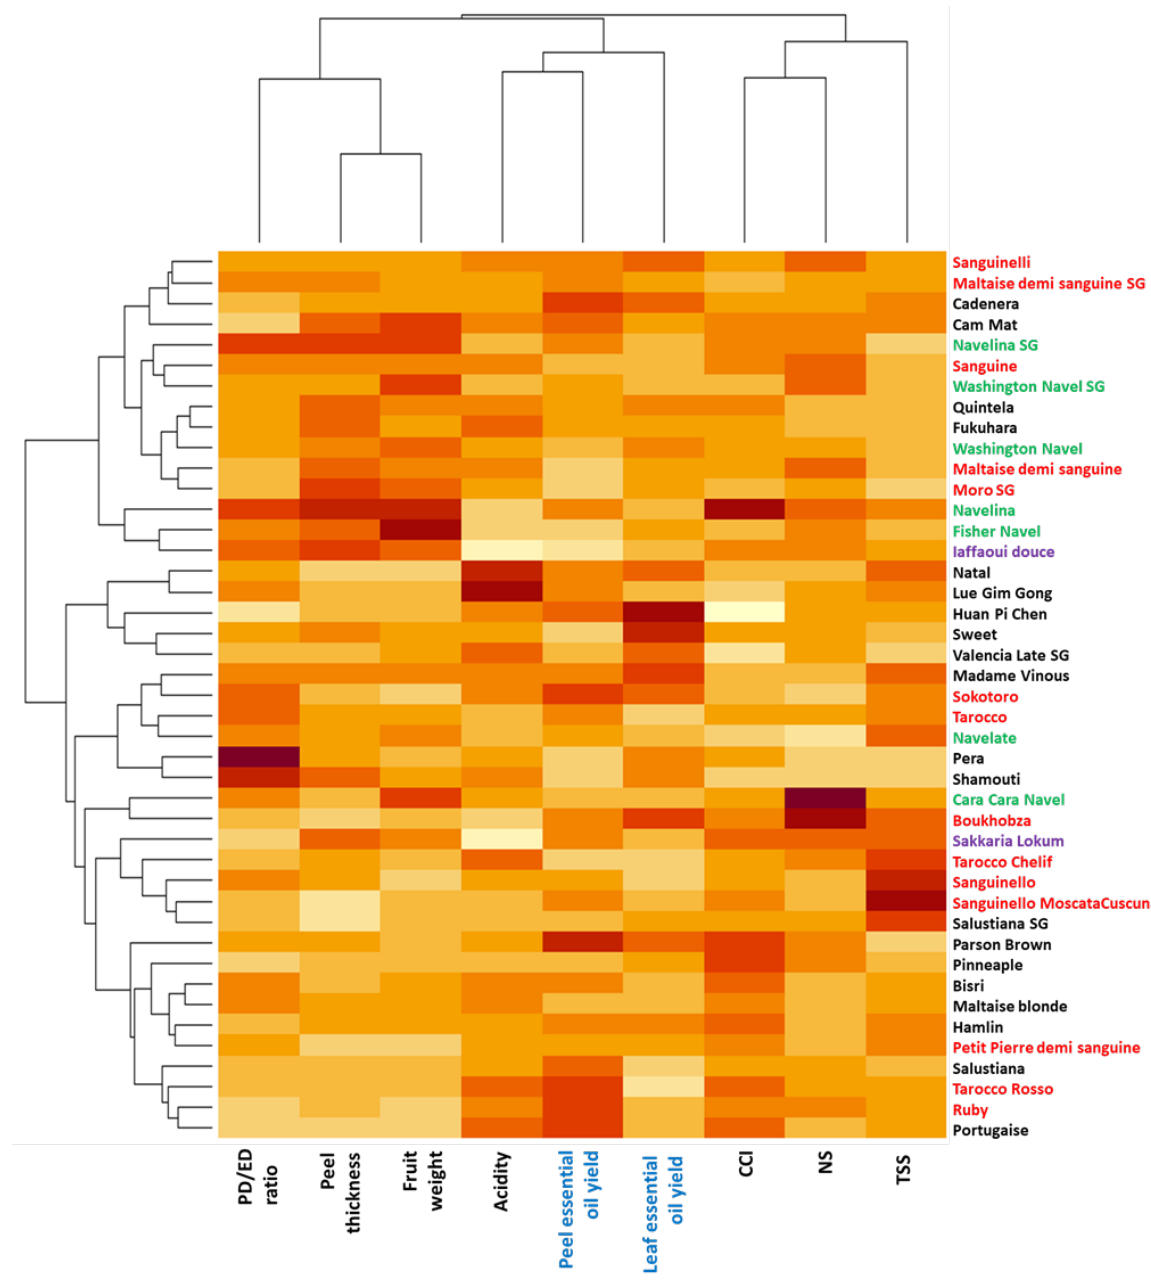
Figure 2. A heatmap representing the phenotypic diversity of the 43 orange cultivars based on the 8 pomological descriptors. The color range from yellow to dark red indicates the degree of value of the observed trait in the orange population, respectively, from weak to strong. Bloody cultivars are represented in red, navels in green, non-acidic in purple, and classic (blond) cultivars in black. PD: polar diameter, ED: equatorial diameter, CCI: citrus color index, NS: number of fruit segment, TSS: total soluble solids.